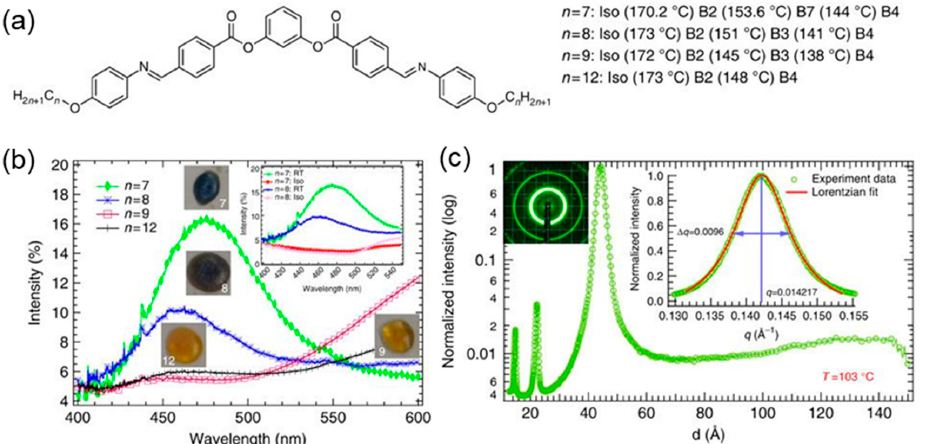
Figure 2. Research on the structural color of HNF with a secondary twist model. ( a ) Chemical structure and thermal phase transition of P-n-OPIMB homologues. ( b ) A reflective spectrum of the droplets of each HNF, which is randomly oriented but has a secondary twisted superstructure. ( c ) XRD results of HNF showing a polycrystal-like ring pattern demonstrates randomly oriented HNF. Reprinted with permission from [49], Copyright 2014, Springer Nature.